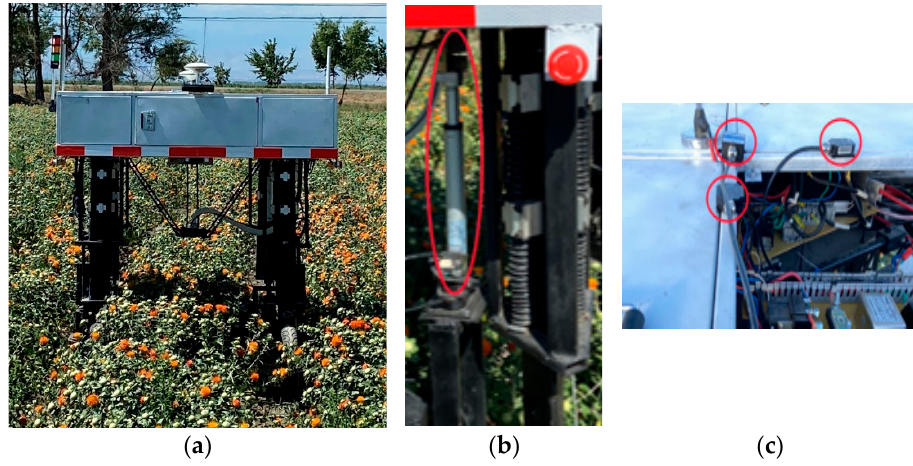
Figure 8. Field test of the mobile platform. ( a ) The overall structure of the mobile platform. ( b ) The installation position of the electric push rod. ( c )The installation position of the IMU.